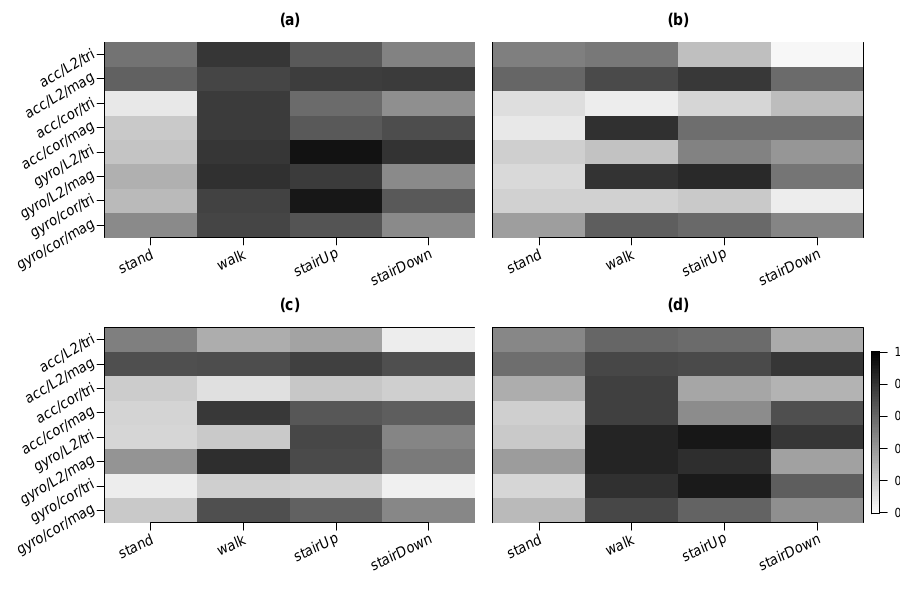
Figure 6. Average sensitivity across subjects for the test data collected in Step 4 (varying orientation of front pocket phone). The four panels correspond to the four potential orientations: ( a ) phone upside down with screen facing the leg; ( b ) phone upside down with screen not facing the leg; ( c ) phone right side up with screen facing the leg; ( d ) phone right side up with screen not facing the leg. Each panel gives the results for the front pocket phone. See Figure 4 for further